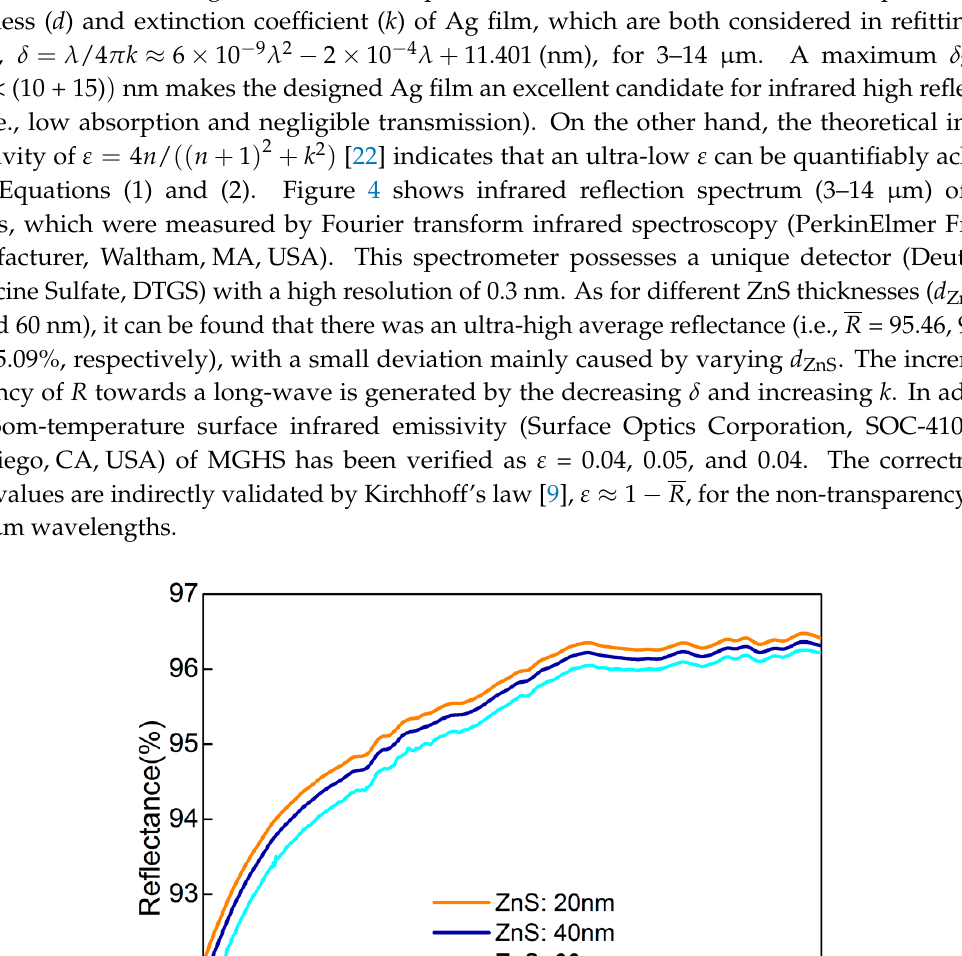
Figure 3. ( a ) The simulated (green crosses) and measured (red crosses) CCs with similar color